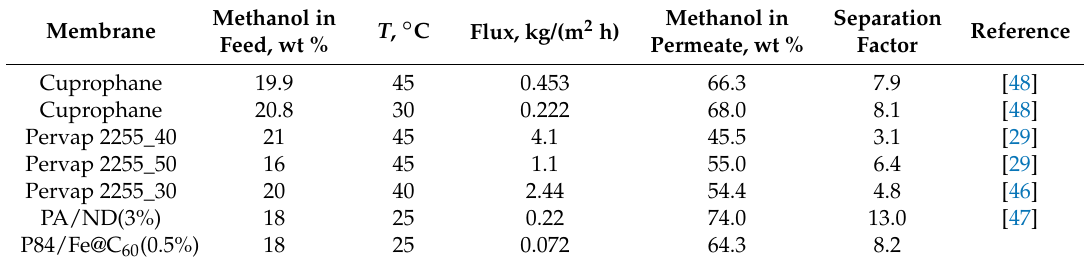
Table 5. Comparison of transport properties of the present P84/Fe@C 60 (0.5%) membrane with literature data on the pervaporation of methanol—methyl acetate